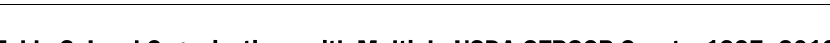
Table 3. Lead Organizations with Multiple USDA CFPCGP Grants, 1997–2012